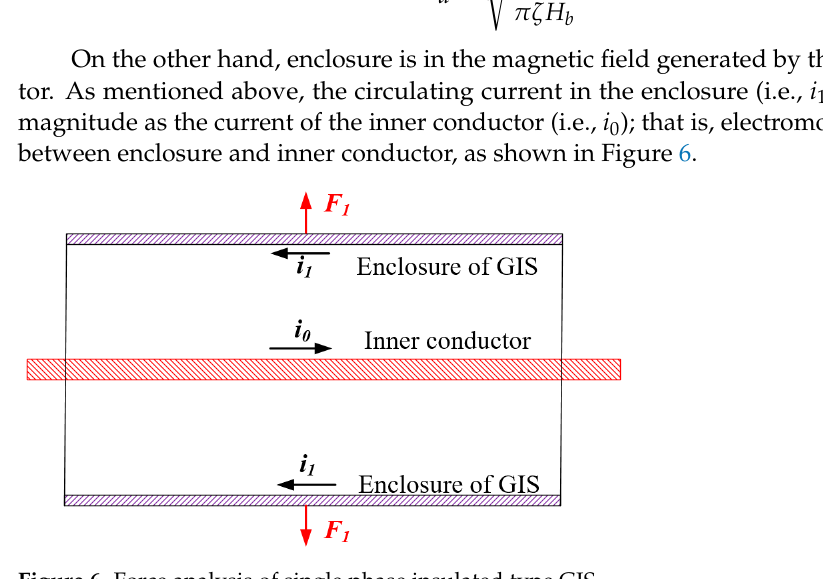
Figure 6. Force analysis of single phase insulated type GIS.